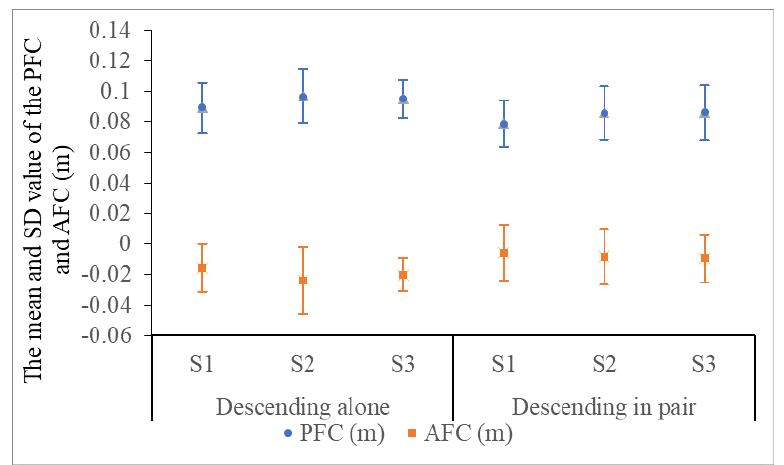
Figure 10. The mean value and SD of FC for all students in two ESs at three sites.